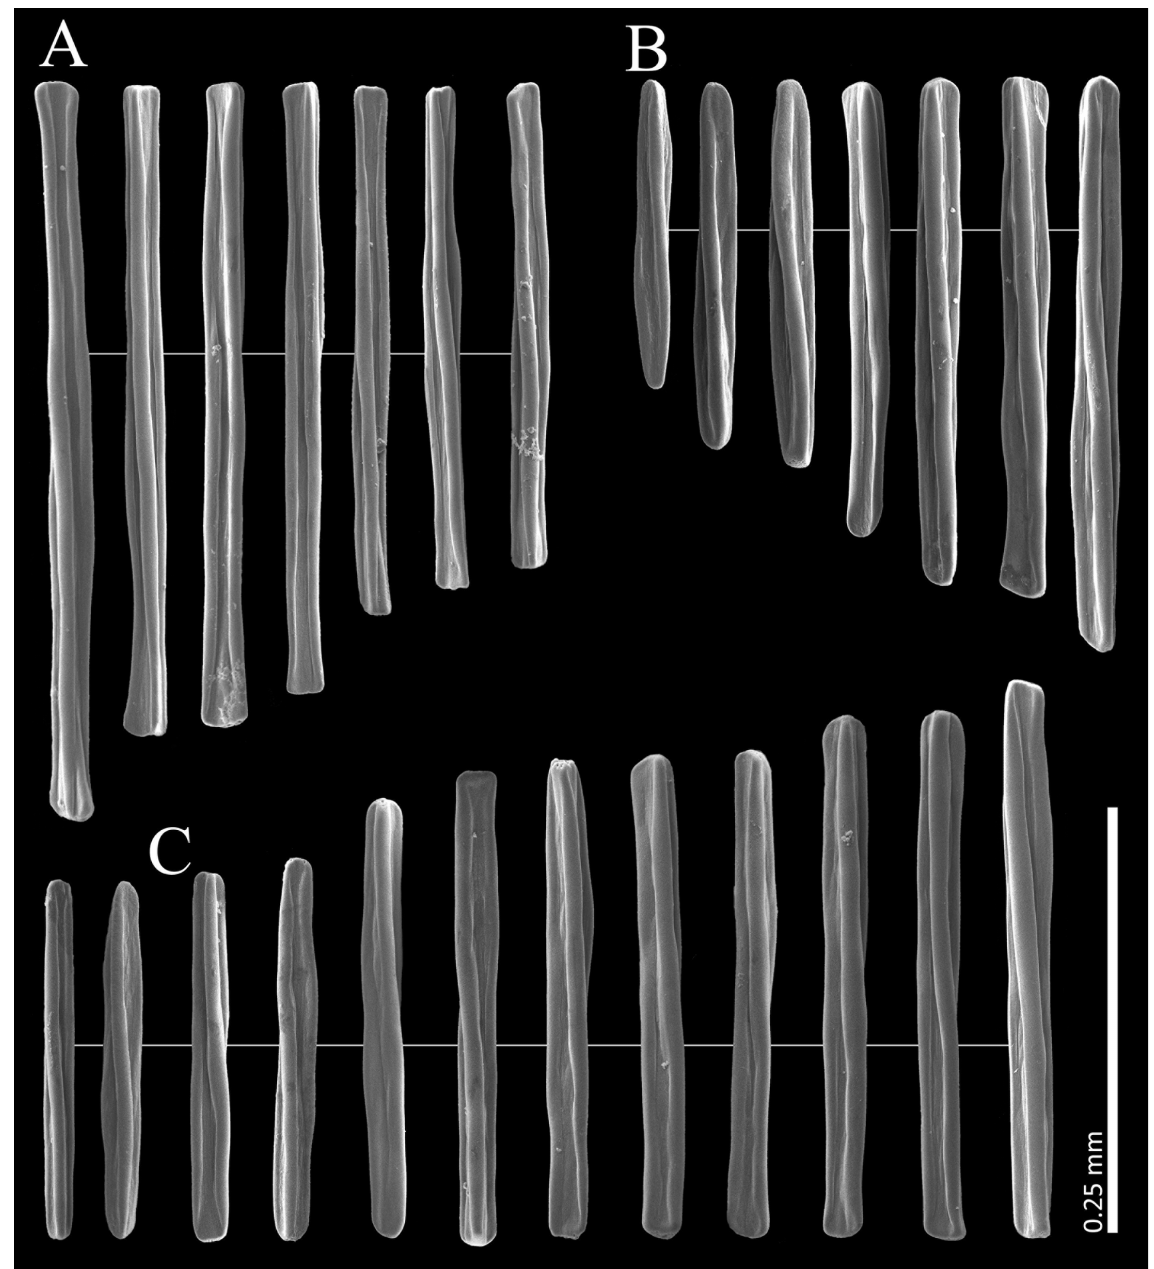
Fig. 11. Gyrophyllum hirondellei Studer, 1891, BECA (OPEN-660). SEM photographs of sclerites. A . Rachis interior. B . Peduncle exterior. C . Peduncle